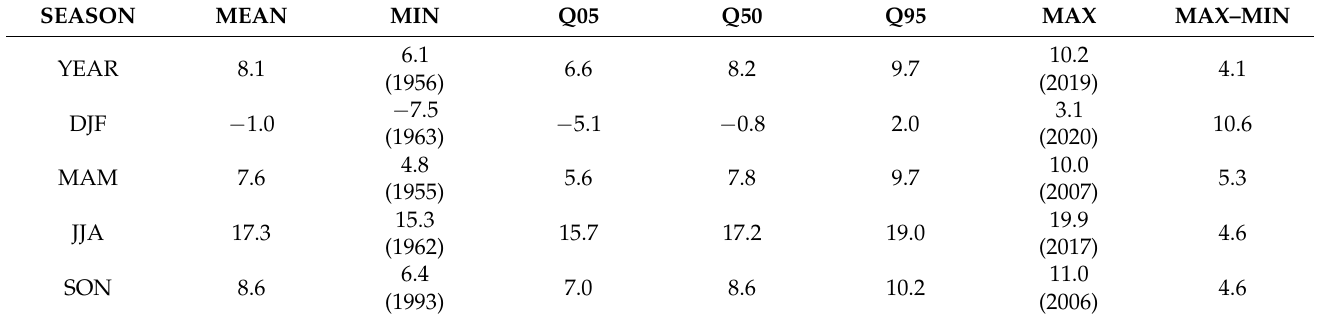
Table 1. General characteristics of air temperature variability in Poland 1951–2021. MEAN, average; MIN, minimum recorded value, with year of occurrence in parentheses; Q05, 5% quantile; Q50, median; Q95, 95% quantile; MAX, maximum recorded value, with year of occurrence in parentheses; MAX–MIN,